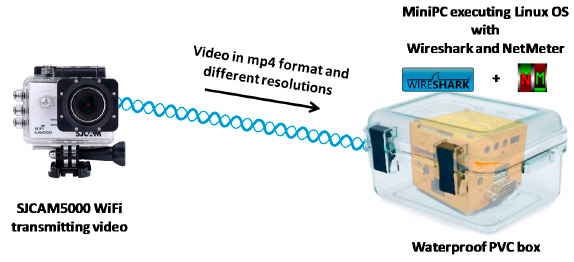
Figure 1. Test bench for video characterization.